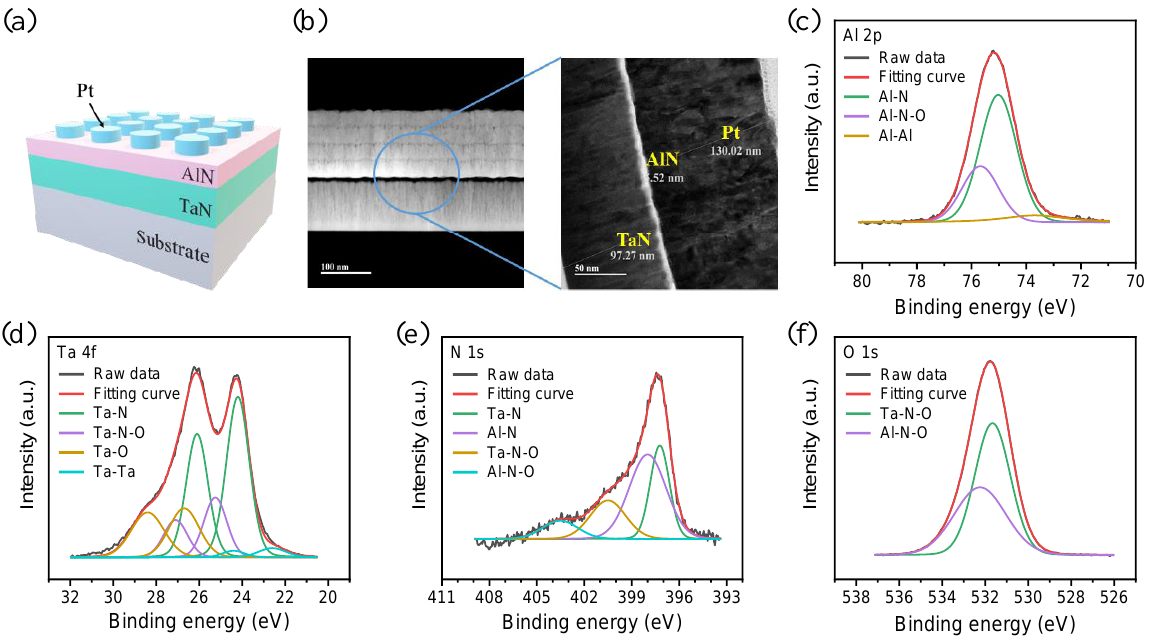
Figure 1. ( a ) Schematic of structure and components of Pt/AlN/TaN device. ( b ) TEM image. XPS spectra of ( c ) Al 2p, ( d ) Ta 4f, ( e ) N 1s, and ( f ) O 1s scan AlN/TaN within 10 nm.